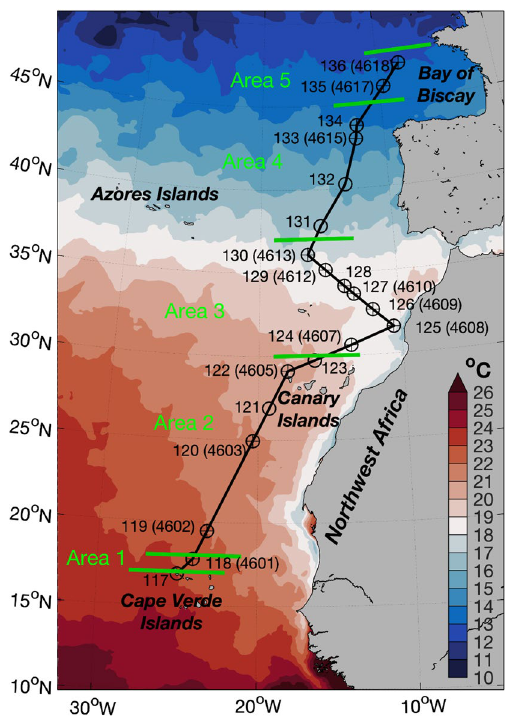
Figure 1. Map of the study area with sea surface temperature (°C) averaged over the period 2–22 May 2019. The Sea Surface Temperature (SST) data are daily means from satellite data and product of the Operational Sea Surface Temperature and Ice Analysis (OSTIA) system run by the UK Met Office 30 . Locations of the CTD stations (circles), and macroplankton trawls (+). The CTD stations are numbered from 117 to 136, and the trawl stations (in parentheses) from 4601 to 4618. Only stations used in the analysis are numbered. The green lines represent the five areas defined in this study according to the distribution patterns of acoustic backscatter observed (see “Results” section below). This figure was created using MATLAB, version R2018a from MathWorks (https:// www. mathw orks.